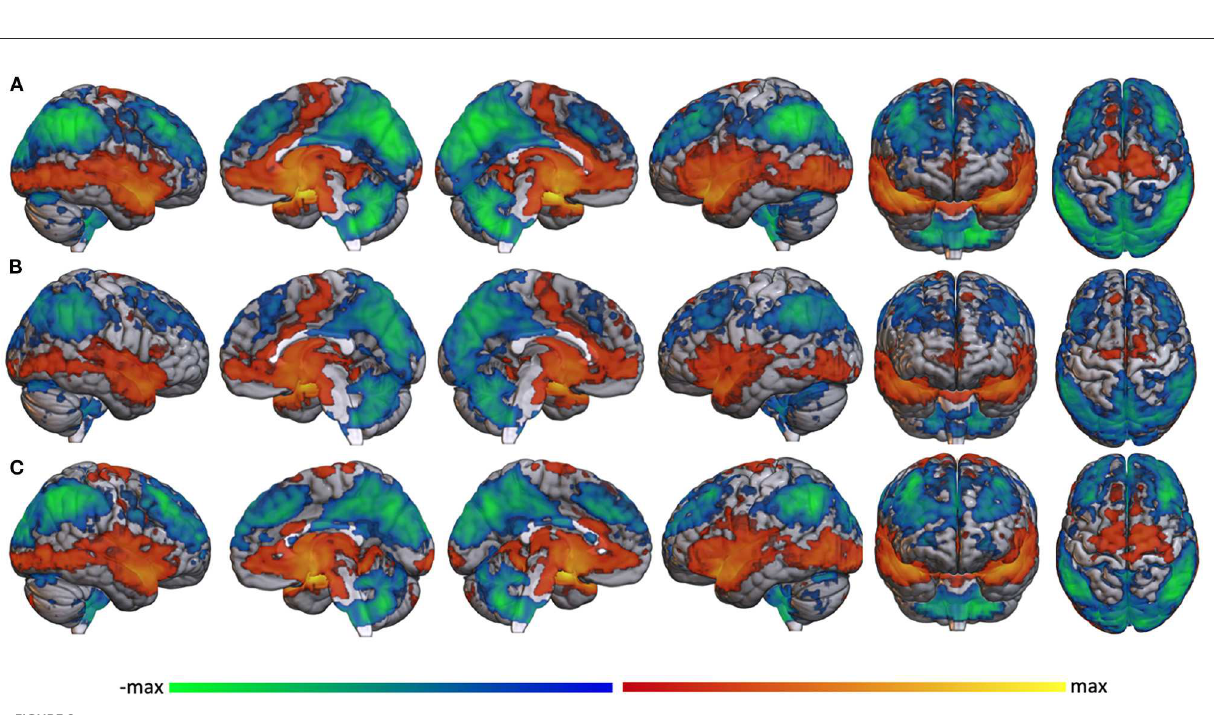
FIGURE2 Whole brain functional connectivity with amygdala. Voxel-wise whole brain resting state functional connectivity with bilateral amygdala in (A) the whole study sample, (B) the TBI-group, and (C) the mTBI group regardless of PTS symptom severity. Warm colors represent significant positive correlation with amygdala; cool colors represent significant negative correlation with